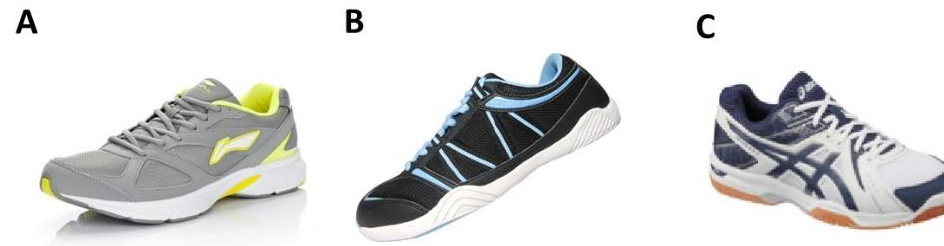
Table 1. The descriptive statistics (Mean ± SD) and statistical result of force platform variables dur- ing jump rope